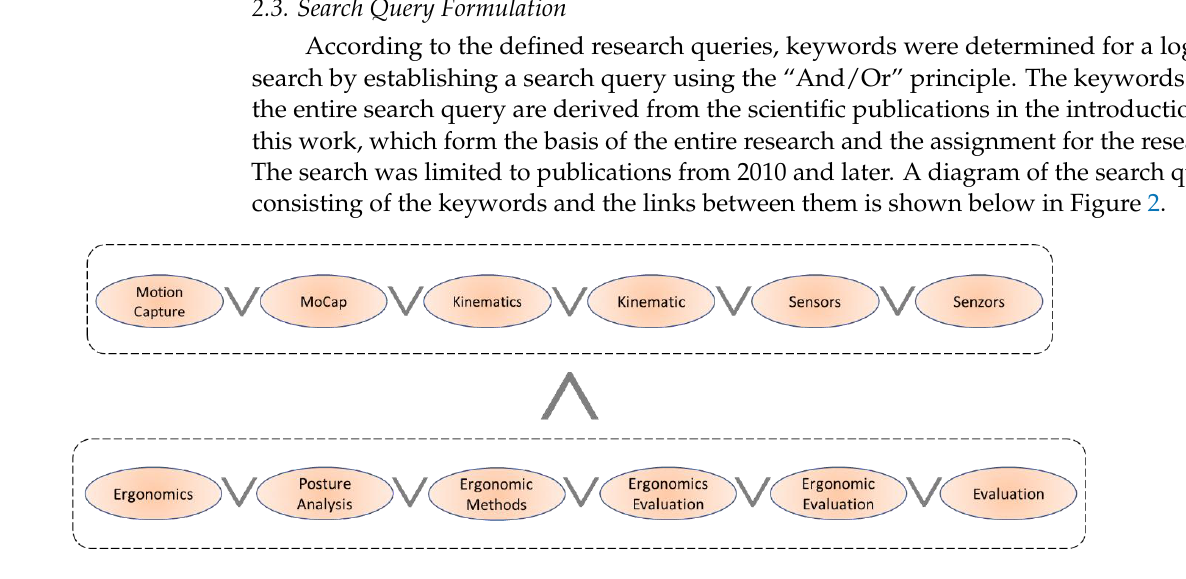
Figure 2. Search query formulation. Source: own processing.